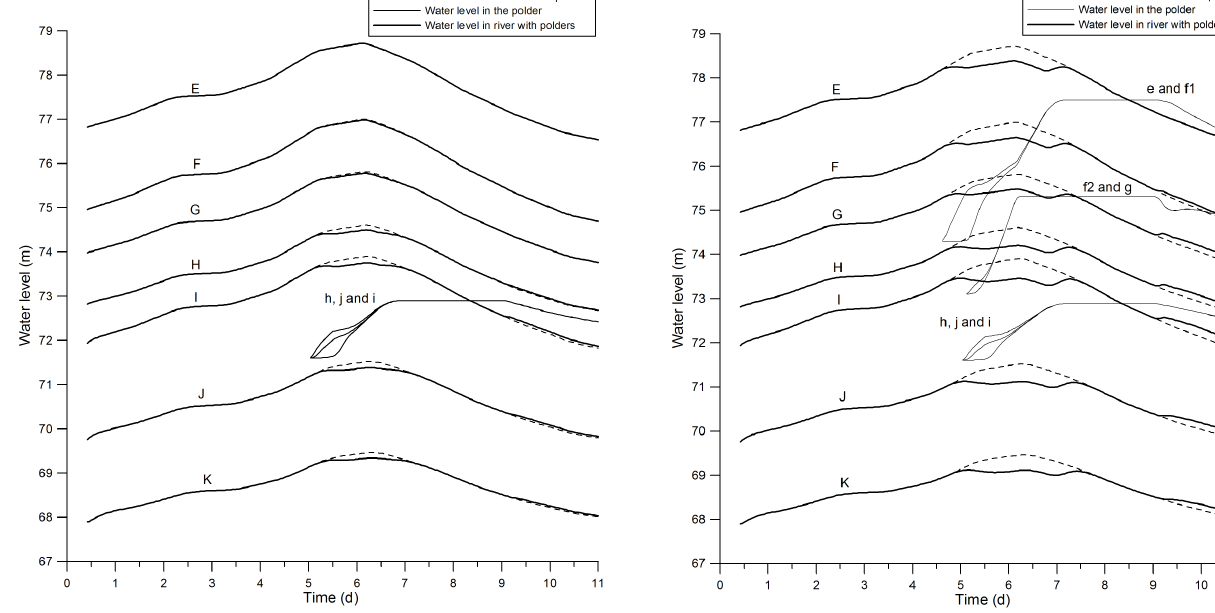
Fig. 14. Water levels in the river, P1+P3 and P4. See Fig. 3 for river locations E to